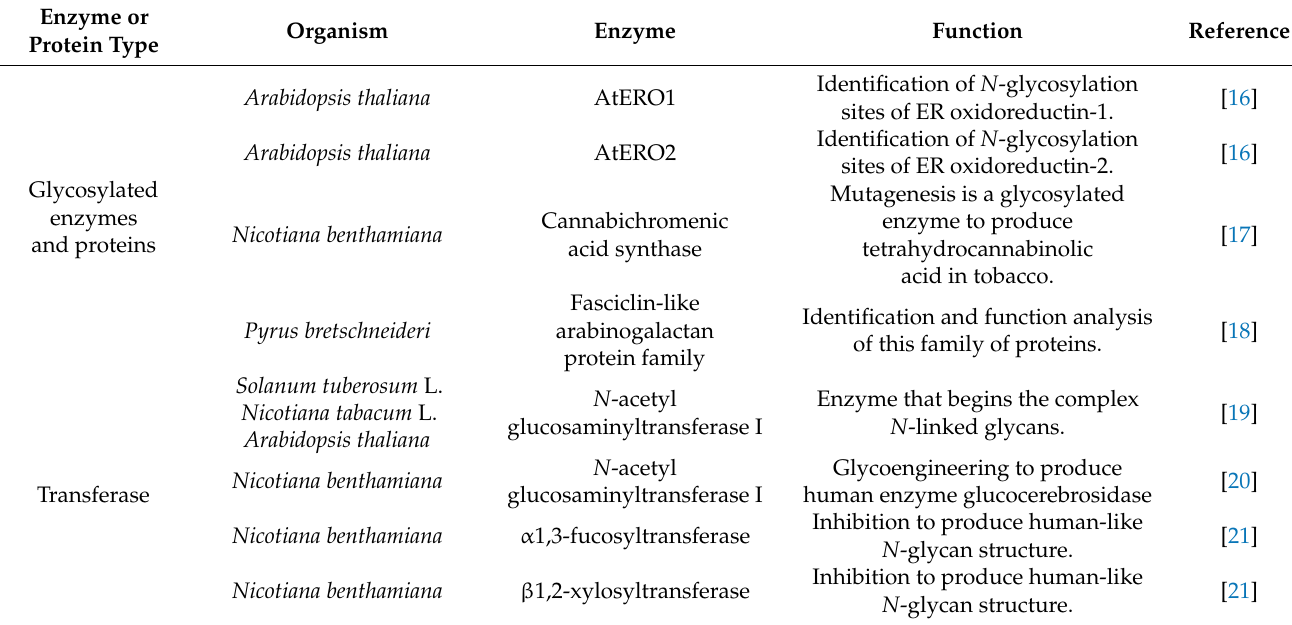
Table 1. Summary of principal research about N -glycosylation and O -glycosylation in plant proteins since 2000. This table contains glycosylated proteins, glycosyltransferases, glycosylhydrolases, and transglycosylase. Enzyme